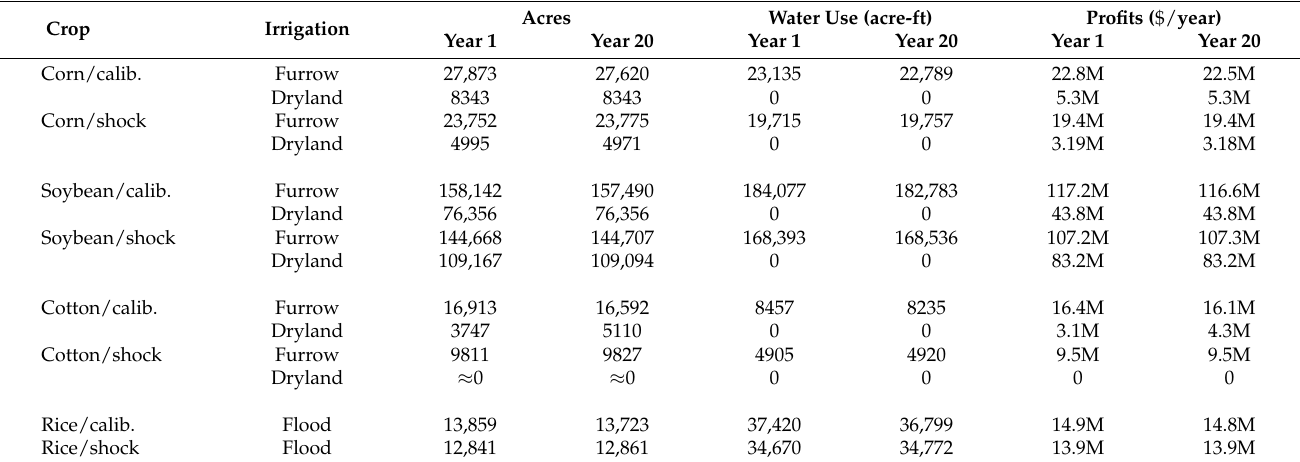
Table 3. Salient Positive mathematical programming results for 20 simulated years, by crop and practice. Crop Irrigation